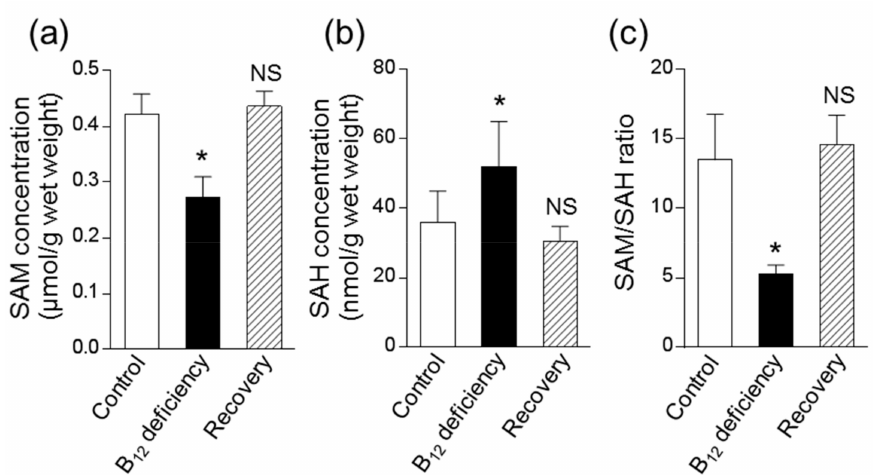
Figure 5. E ff ects of vitamin B 12 deficiency on S-adenosylmethionine and S-adenosylhomocysteine contents of C. elegans . S-Adenosylmethionine (SAM, a ) and S-adenosylhomocysteine (SAH, b ) were determined in B 12 -deficient and control worms using HPLC, and then the SAM / SAH ratio ( c ) was calculated. After B 12 -deficient worms were grown for three generations under B 12 -supplemented conditions, these values were determined in the B 12 -treated worms (shown as “Recovery”). Data represent the mean ± SEM of three independent experiments. * p < 0.05 versus Control group. NS represents no significant di ff